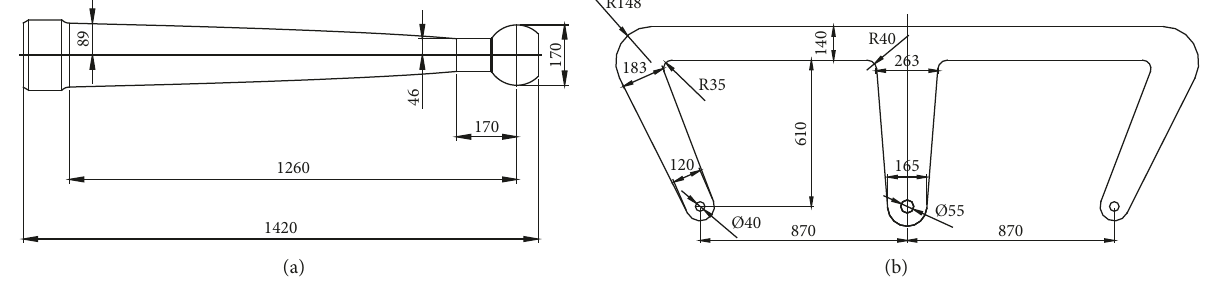
Figure 16: (a) Cylindrical and (b) E-shaped damper dimensions.